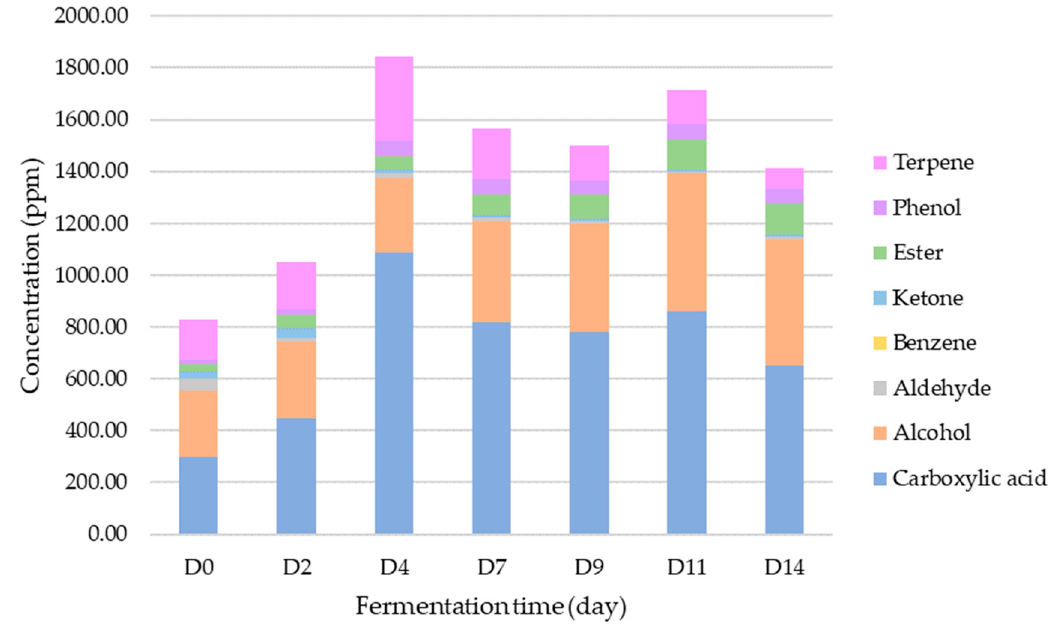
Figure 3. Changes in average contents (ppm) of different classes of VOCs with kombucha fermentation time (day) at 30 °C.